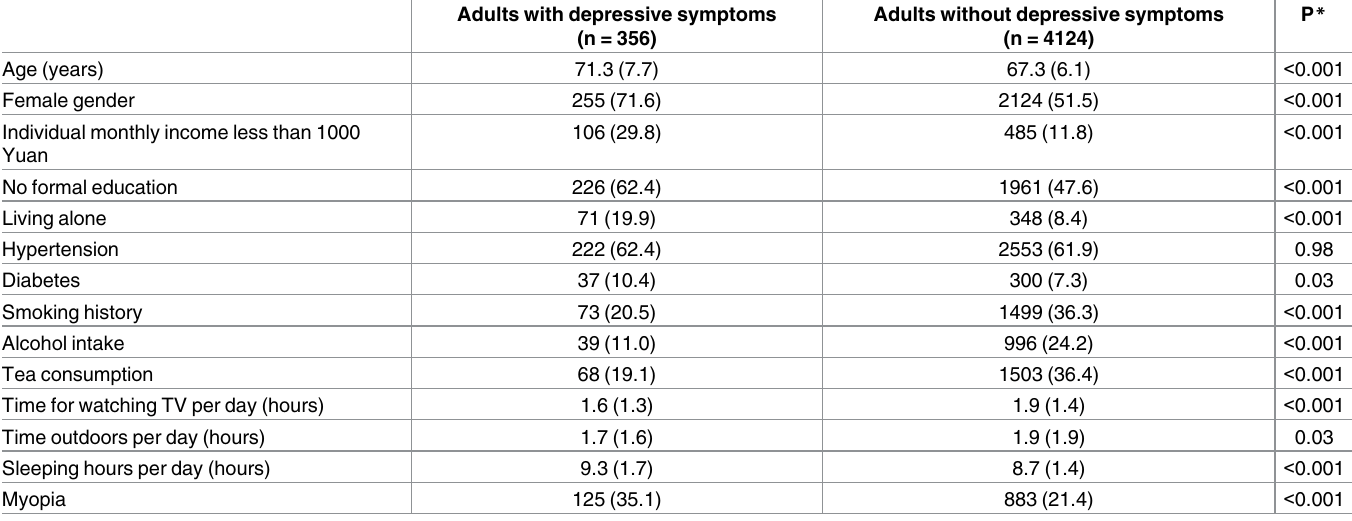
Table 1. Characteristics of study participants by depression